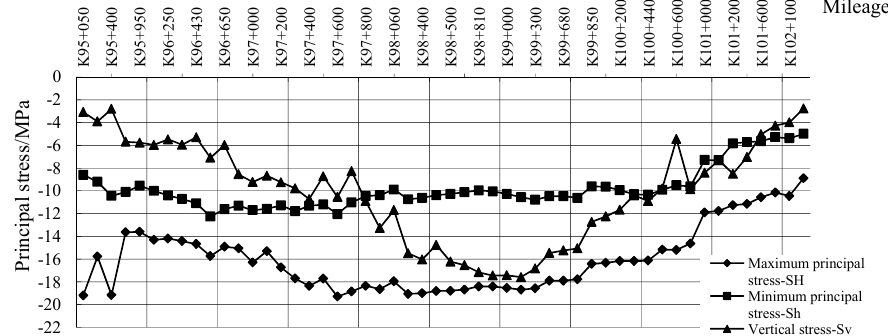
Figure 4. The principal stress field distribution along the axial direction of Cang Ling Tunnel.